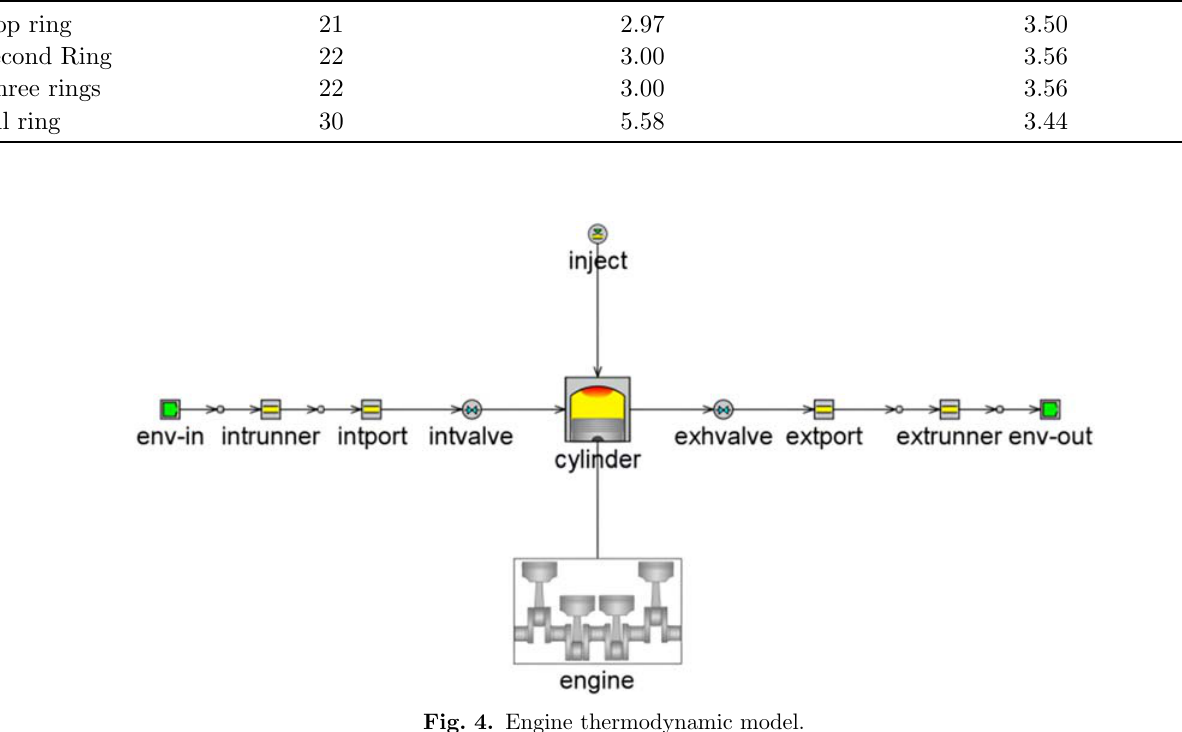
Fig. 4. Engine thermodynamic model.